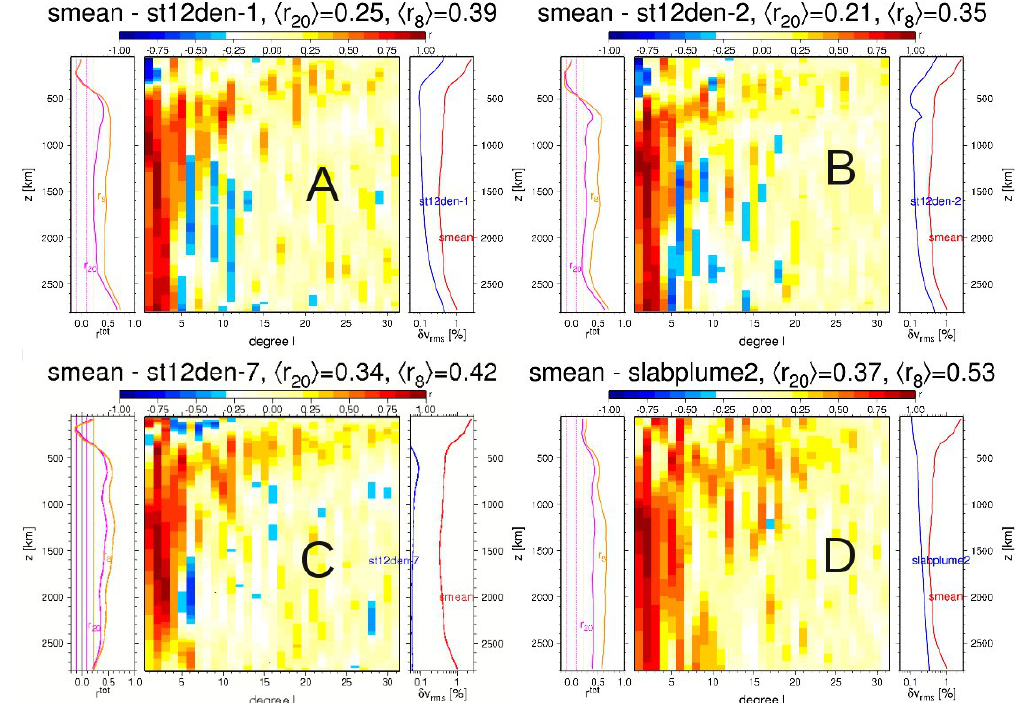
Fig. 8. Correlation between geodynamic models and composite tomographic model SMEAN (Becker and Boschi, 2002): The left parts of each panel give correlations r 8 for all degrees up to l = 8 and r 20 for all degrees up to l = 20, the center parts correlation as a function of depth and spherical harmonic degree, the right parts give the RMS anomaly of density (for geodynamic models) or seismic wavespeed (for tomography models) as a function of depth. (A) : Model st12den-1, with input of slabs over a wider depth range (and further described in the text). (B) : st12den-2, the model shown in most other figures. (C) : st12den-7, the “slabs only” geodynamic model without thermo- chemical piles and without diffusion of heat across the CMB – otherwise same modeling assumptions as st12den-1. (D) : A model where tilted mantle plumes with moving source at the CMB according to Becker and Boschi (2007) and based on the modeling procedure described in Steinberger and Antretter (2006) have been added to the slab model st12den-7.